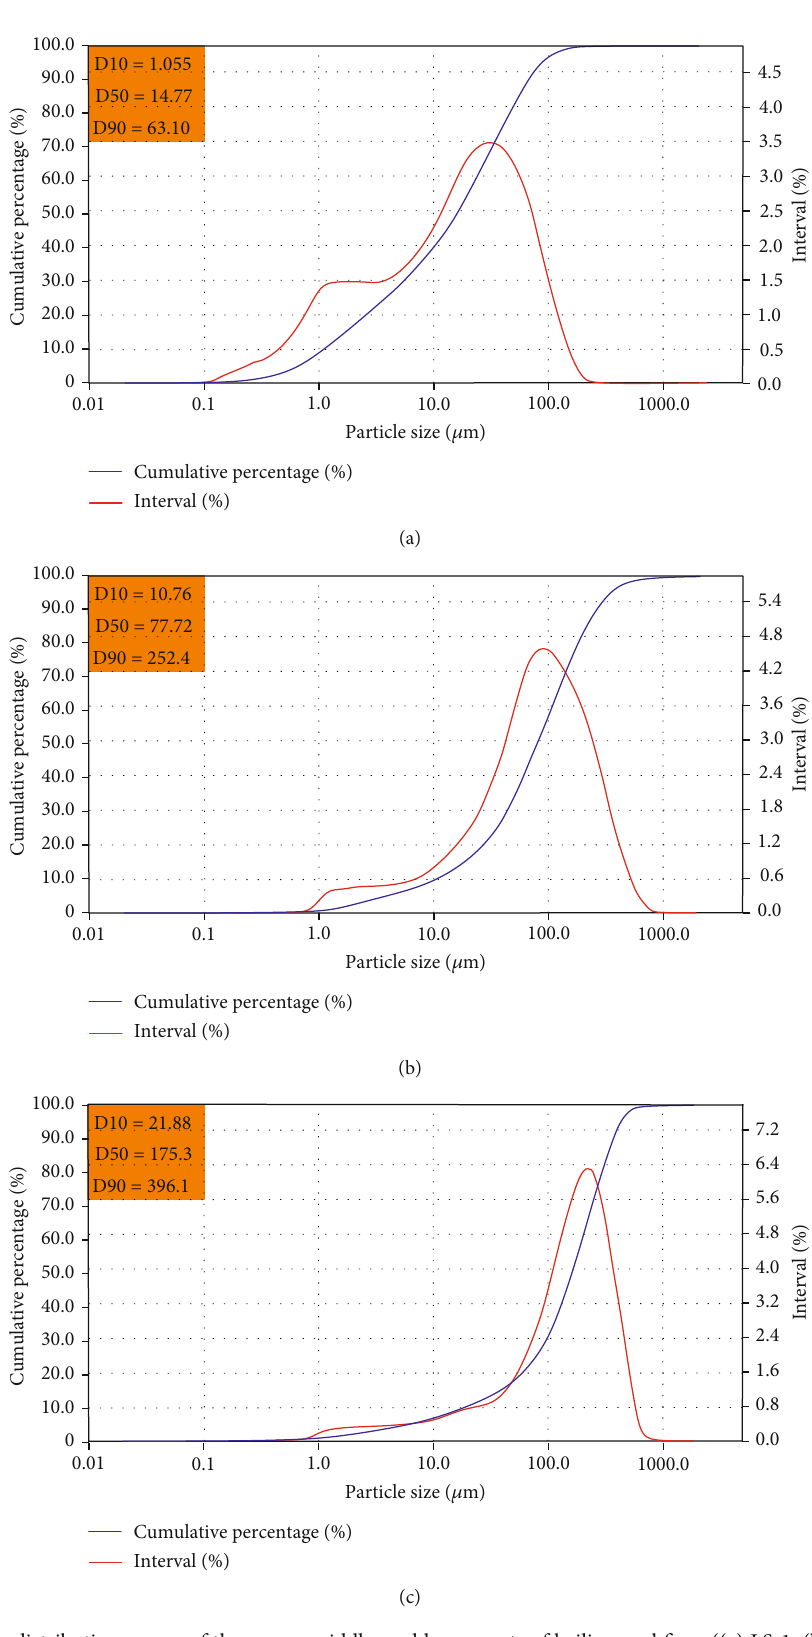
Figure 6: Particle size distribution curves of the upper, middle, and lower parts of bailing coal fi nes ((a) LS-1, (b) LS-2, and (c)